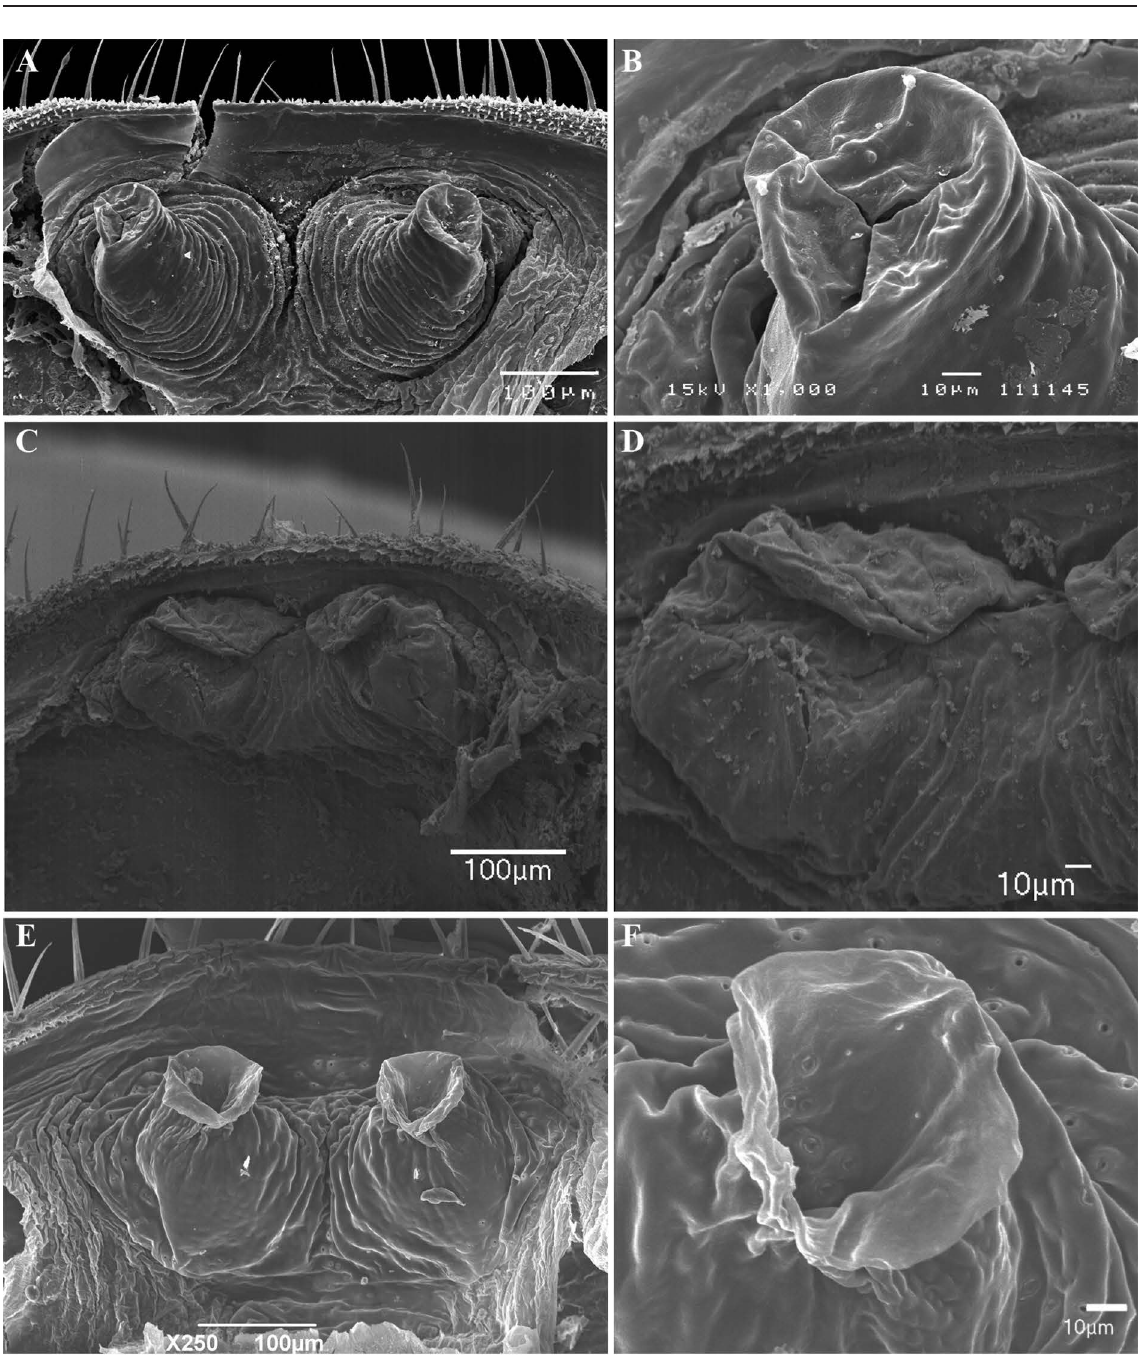
Fig. 7. Charinus Simon, 1892, female gonopods, dorsal view (left column) and detail (right column). A–B . Charinus acaraje Pinto-da-Rocha, Machado & Weygoldt, 2002 (MNRJ 9297). C–D . Charinus palikur sp. nov. (AMCC [LP 3831]) E–F . Charinus sooretama sp. nov.